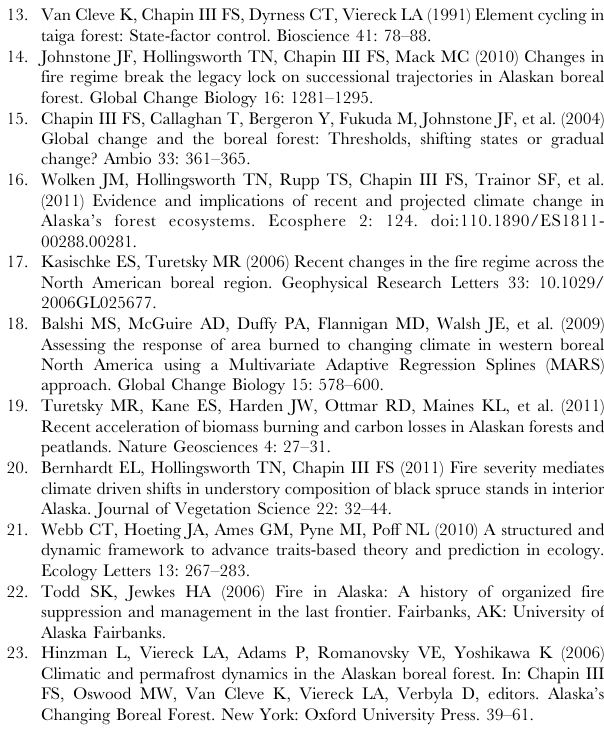
Table S2 Complete vascular and nonvascular species list across all study sites. Vascular species were verified in